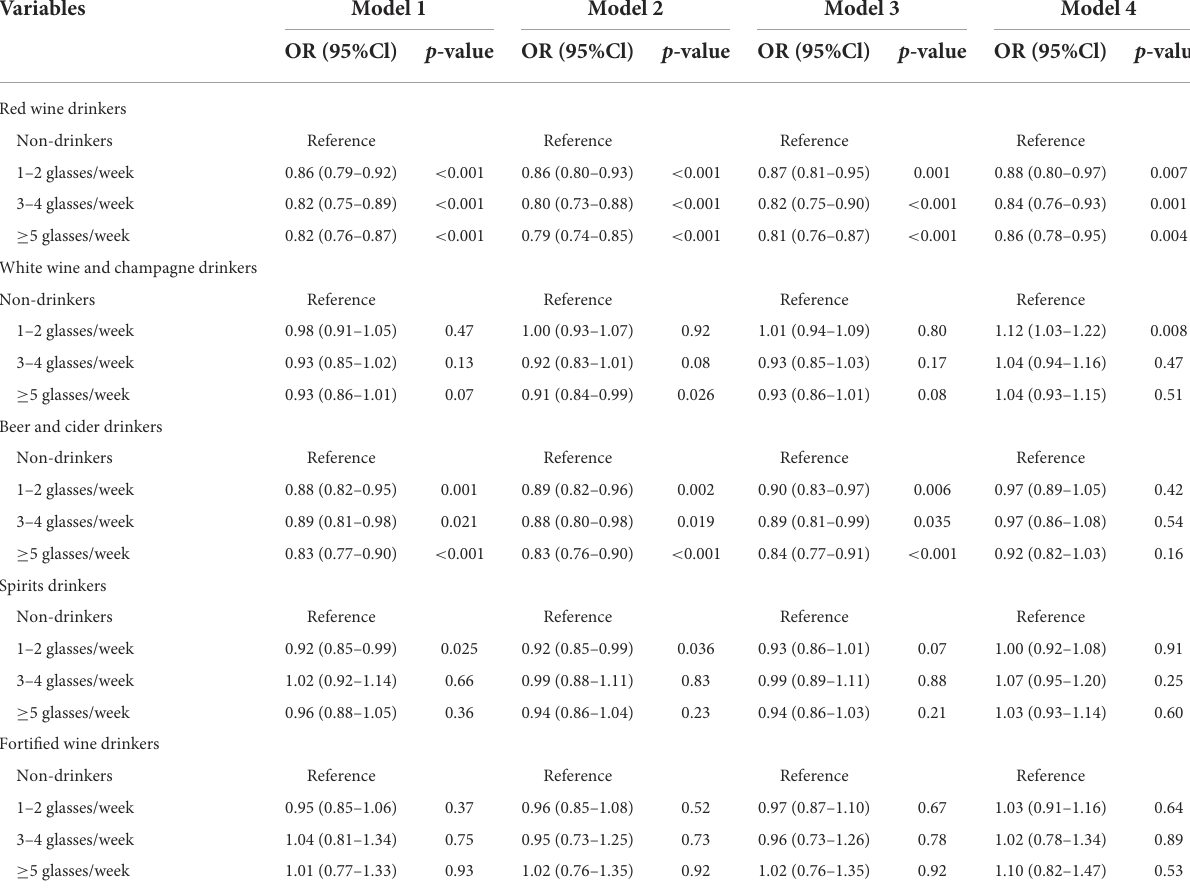
TABLE 2 Association of different subtypes of alcoholic beverages with IBD